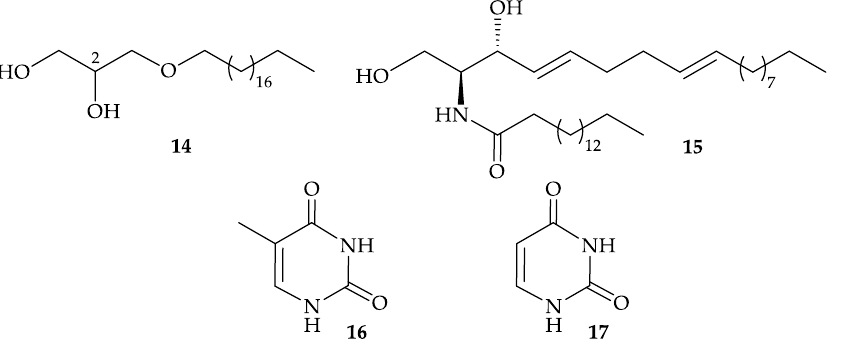
Figure 4. Structures of (±)-1-nonadecyloxy-2,3-propanediol ( 14 ) and (2 S ,3 R ,4 E ,8 E )- N -hexadecanoyl- 2-amino-4,8-octadecadiene-1,3-diol ( 15 ), thymine ( 16 ), and uracil ( 17 ).